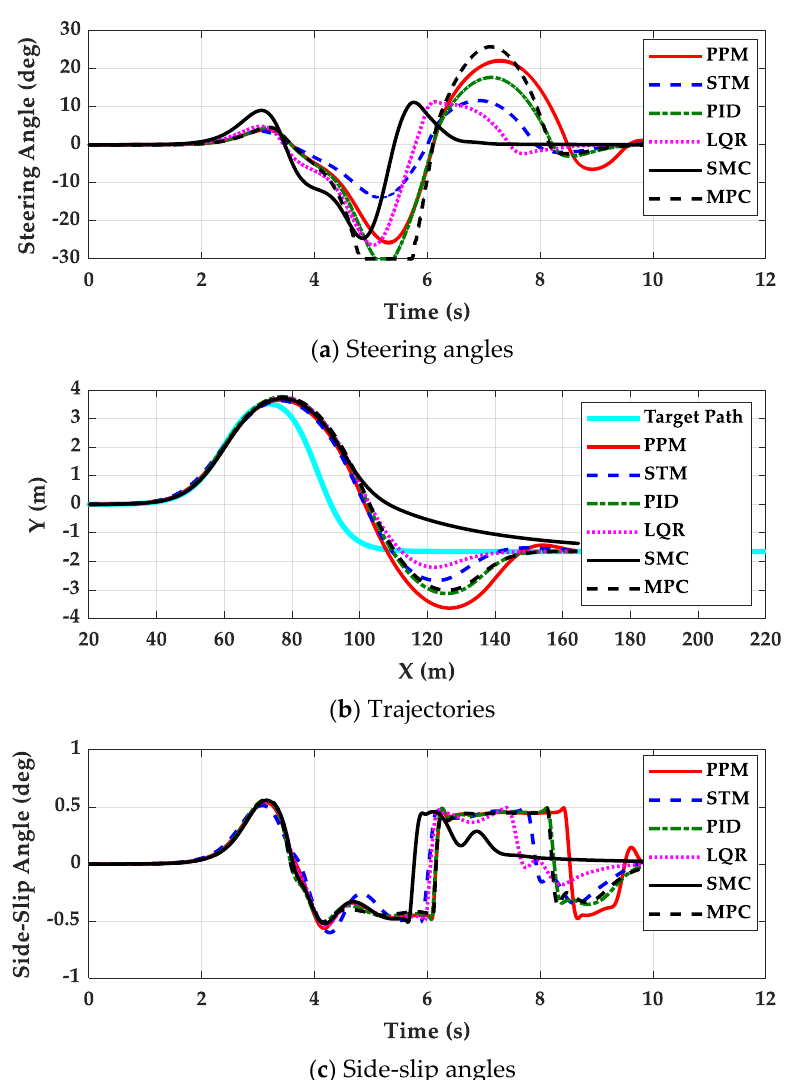
Figure 6. Simulation results of each controller for FWS vehicle on low- µ road obtained from the second set of simulations.